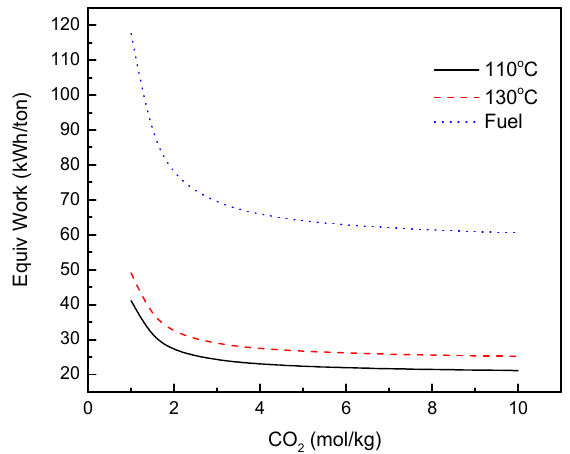
Figure 15. Equivalent work of the FO process using NH 3 -CO 2 as the draw solute.